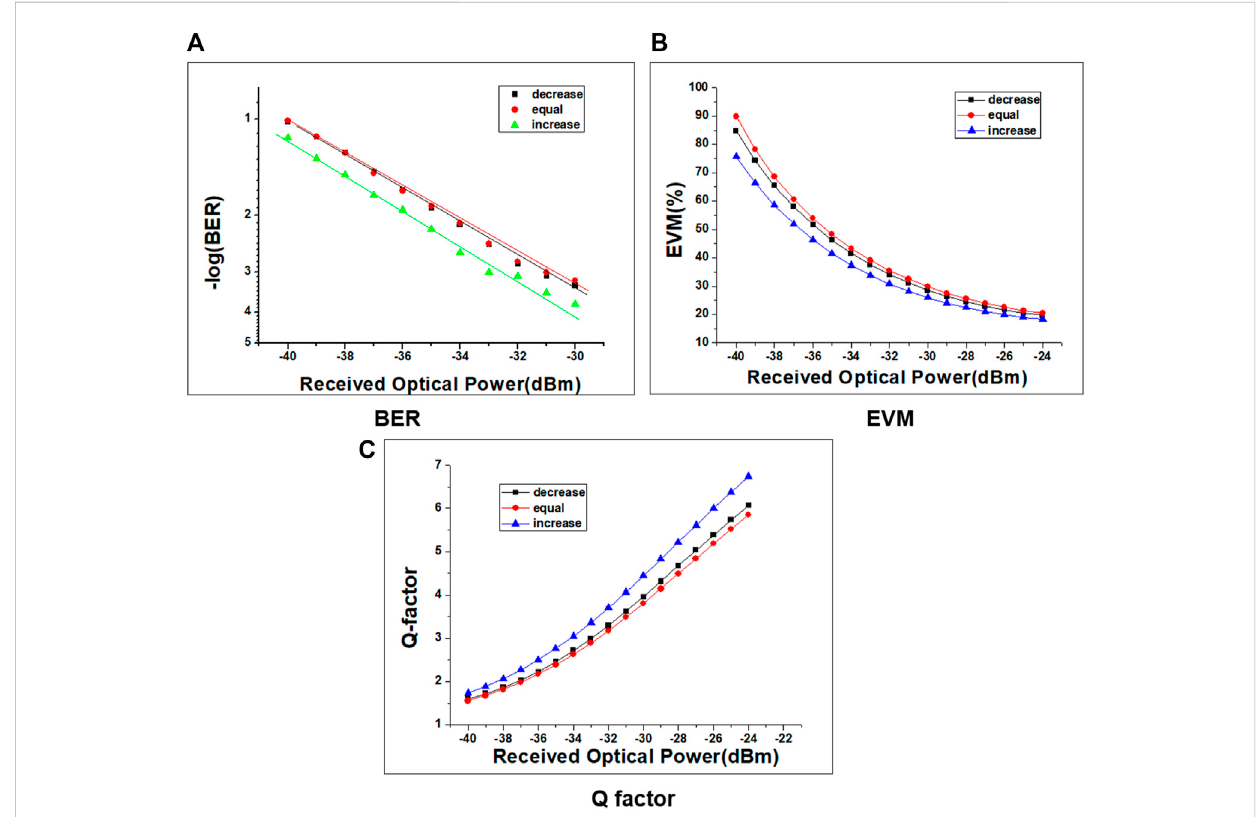
FIGURE 7 BER, EVM, and Q-factor curves under different pilot interval schemes. (A) BER curves; (B) EVM curves; (C) Q-factor curves.